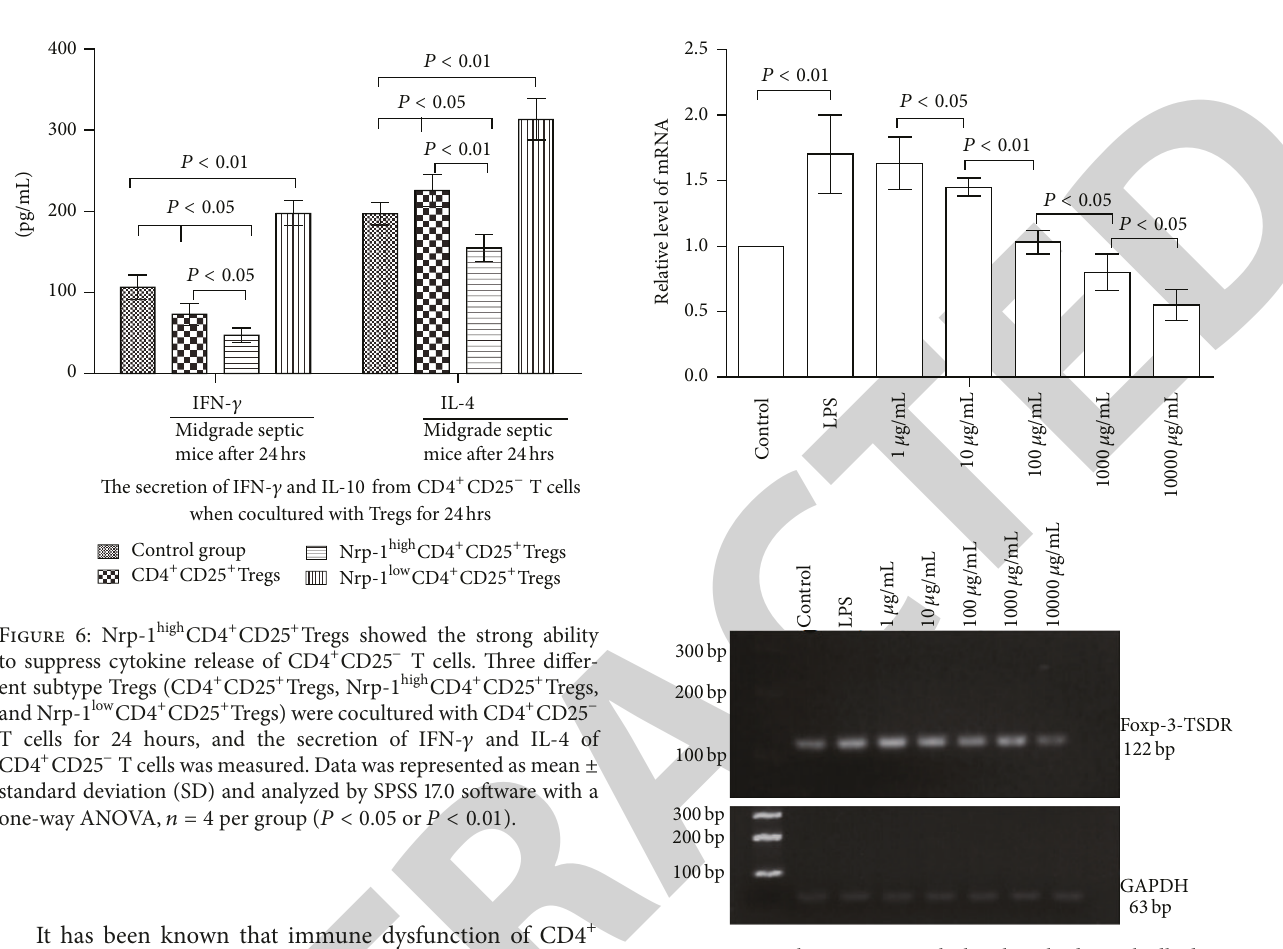
Figure 7: Recombinant Nrp-1 polyclonal antibody markedly down- regulated the demethylation of Foxp-3-TSDR in the stimulated LPS at 24 hours in a dose-dependent manner. Data was represented as mean ± standard deviation (SD) and analyzed by SPSS 17.0 software with a one-way ANOVA, 𝑛 = 4 per group ( 𝑃 < 0.05 or 𝑃 < 0.01